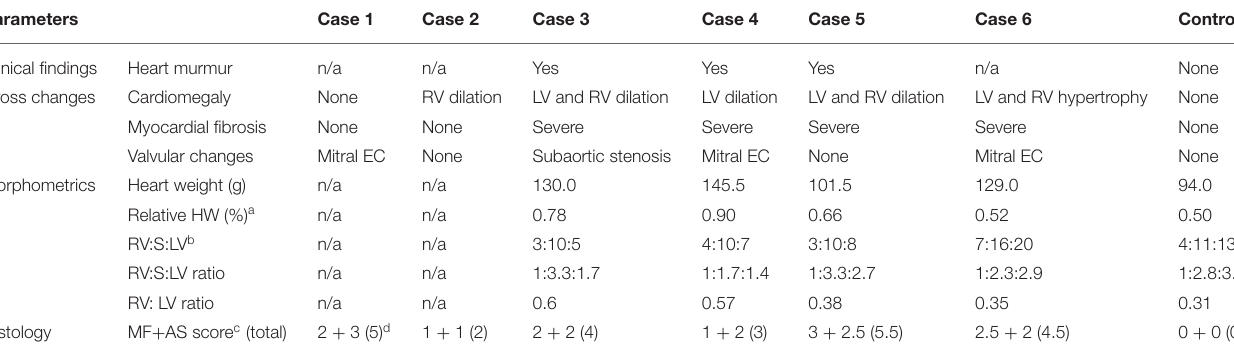
TABLE 4 | Post-mortem heart findings in six Eurasian lynx (subspecies Lynx lynx carpathicus ) from Switzerland affected by cardiomyopathy and a healthy individual (control) for comparison. Parameters